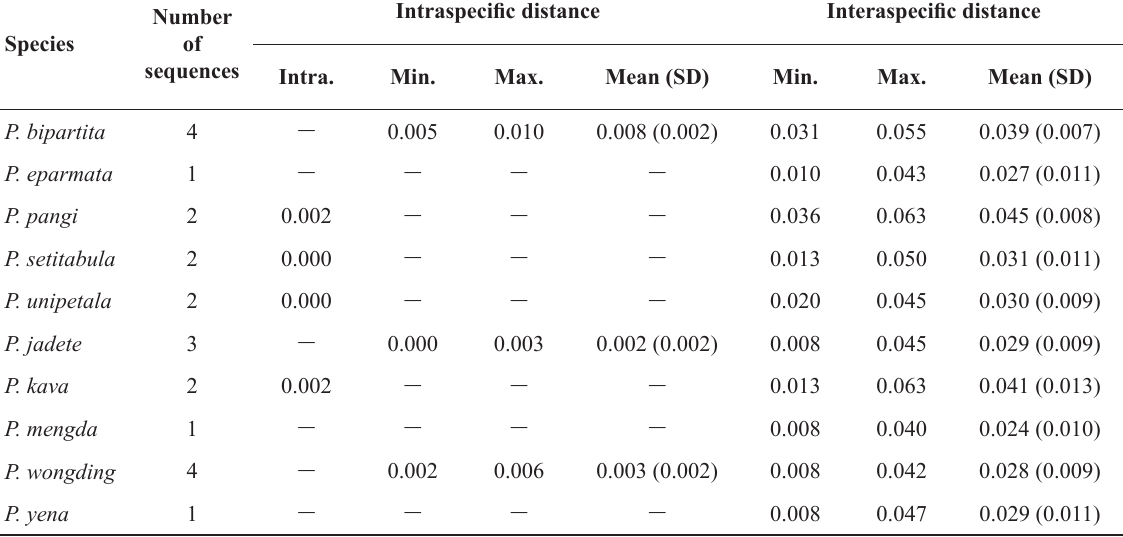
Table 2. Summary of genetic distances. Intra. = intraspecific distance; Min. = minimum intraspecific distance; Max. = maximum intraspecific distance; SD = standard deviation; Min. inter. =